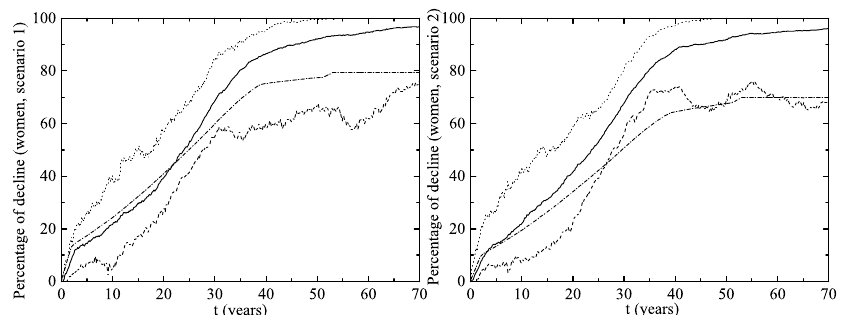
Figure 7. The same as Figure 6 but for MSM.